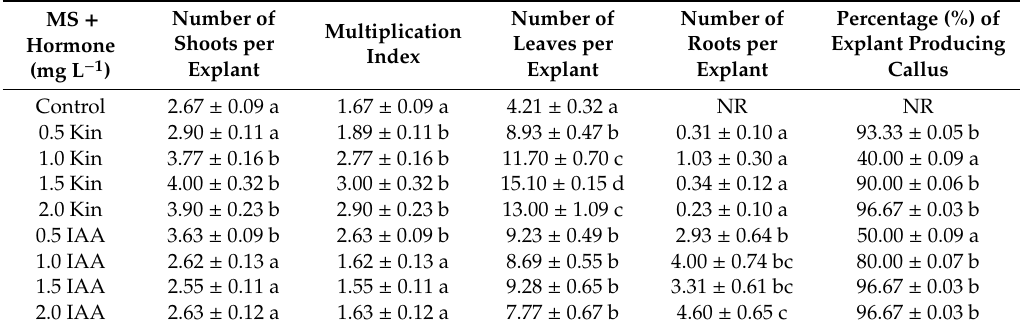
Table 1. E ff ects of single hormone on number of shoots, multiplication index, leaves and roots per explant, and percentage (%) of explant producing callus.